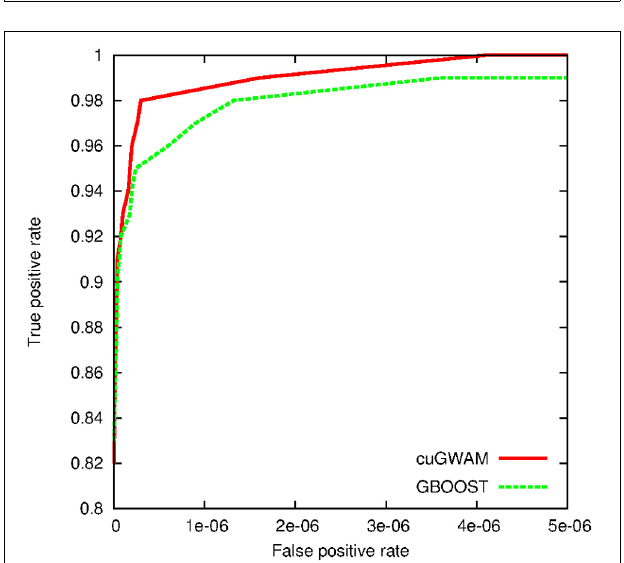
FIGURE 8 | ROC for methods to analyze a continuous trait.